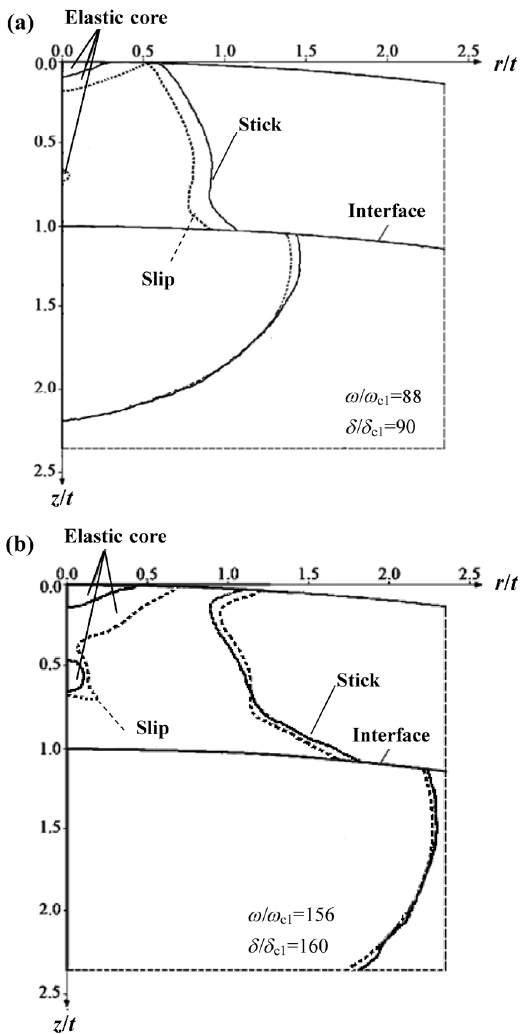
Fig. 9 Evolution of the plastic zones in the coated sphere (  = 0.32, t / R = 0.05,  y_su =  y_co = 0.001 and E co / E su = 2). (a)  /  c1 = 44 and  /  c1 = 47 and (b)  /  c1 = 148 and  /  c1 = 157. is axisymmetric, only half of the model is shown, and both axes are normalized using the coating thickness.